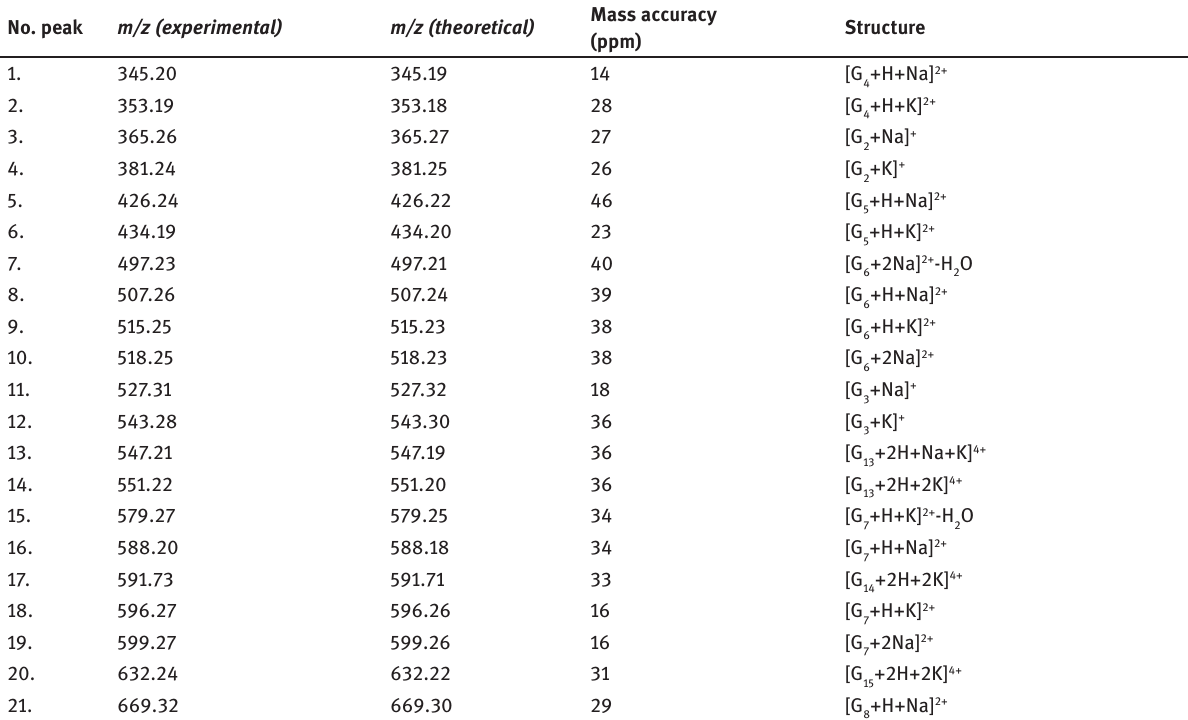
Table 1: Assignment of the major ions in Dex